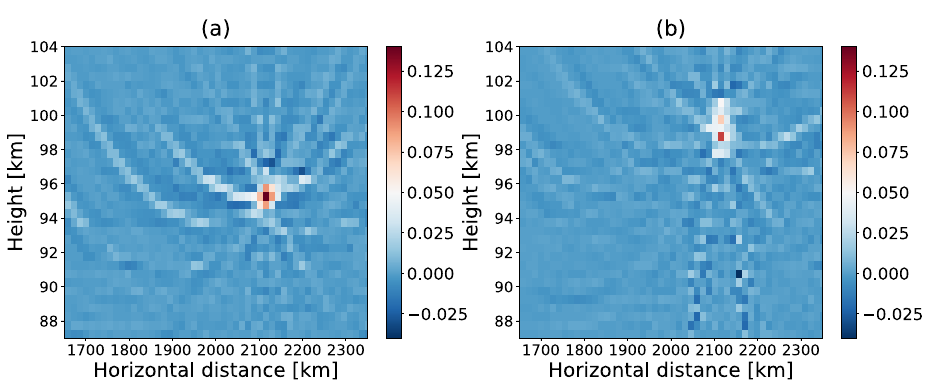
Figure 7. Averaging kernel matrix for two different retrieval points, allocated at the geographical position of highest values (red colour). Panel (a) shows a point coinciding with the observational grid, while panel (b) shows a point whose vertical position is in between two tangent altitudes of the limb observations; for details see text.